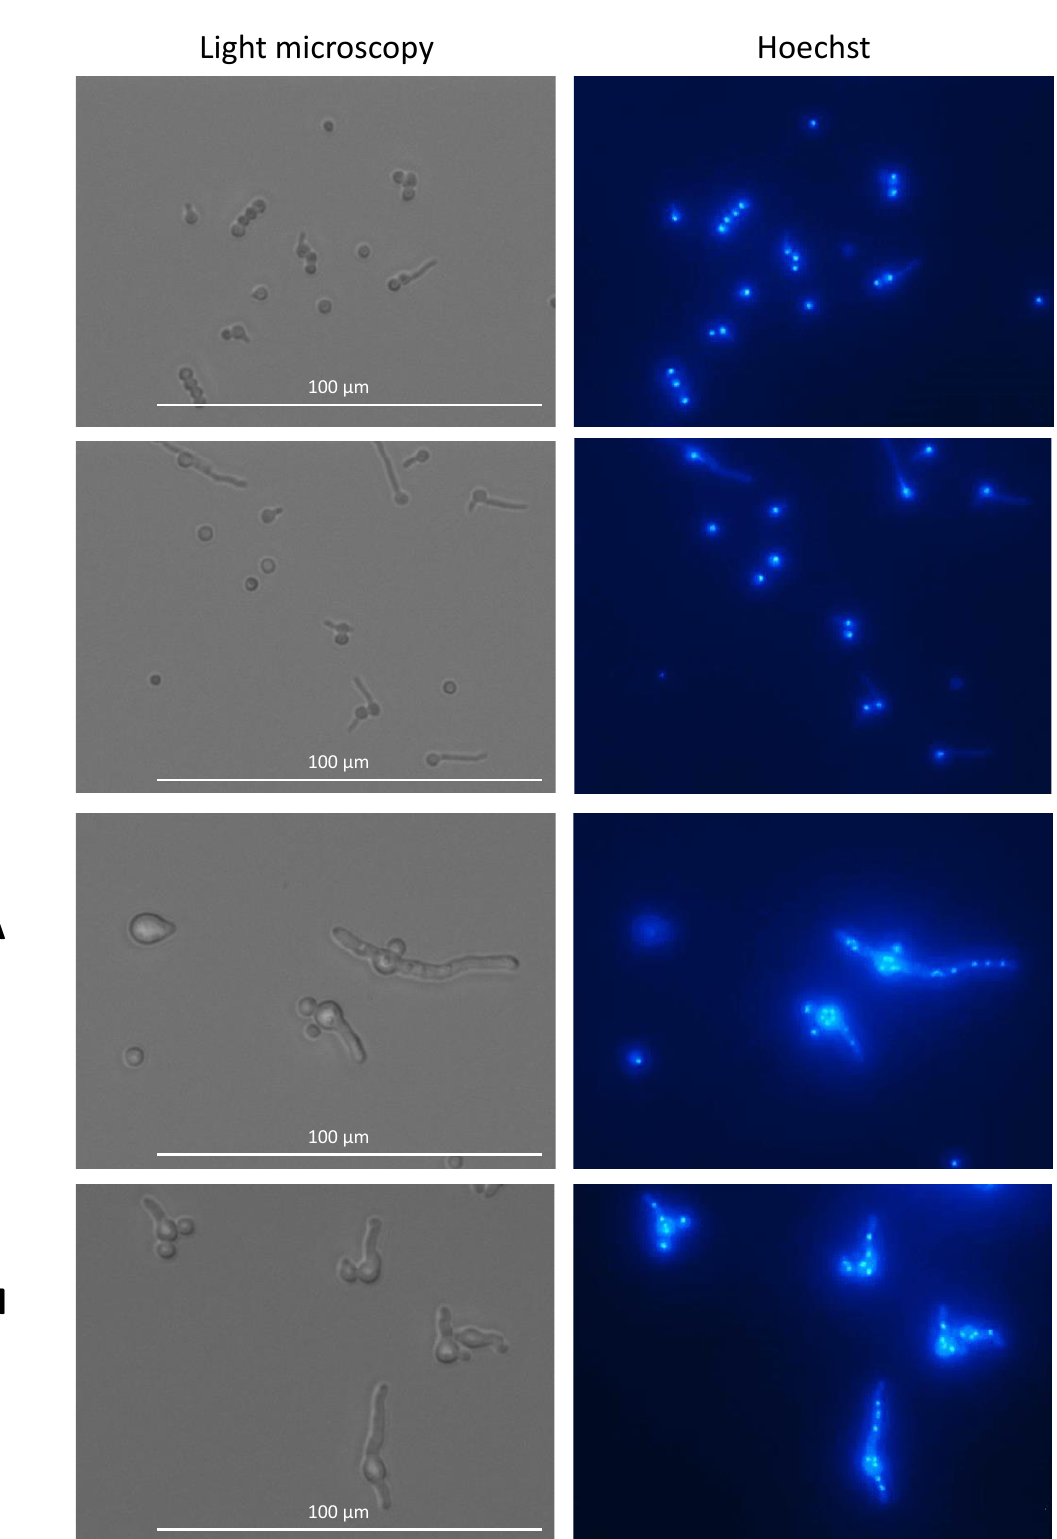
Figure 6. Nuclei in germinating conidia. Germinated conidia in G and GA media only displayed one nucleus per conidium after 24 h of germination. Active nuclear division in MM and GAP media after respectively 11 h and 24 h germination. Staining with Hoechst of germinating conidia; Nucleus staining by